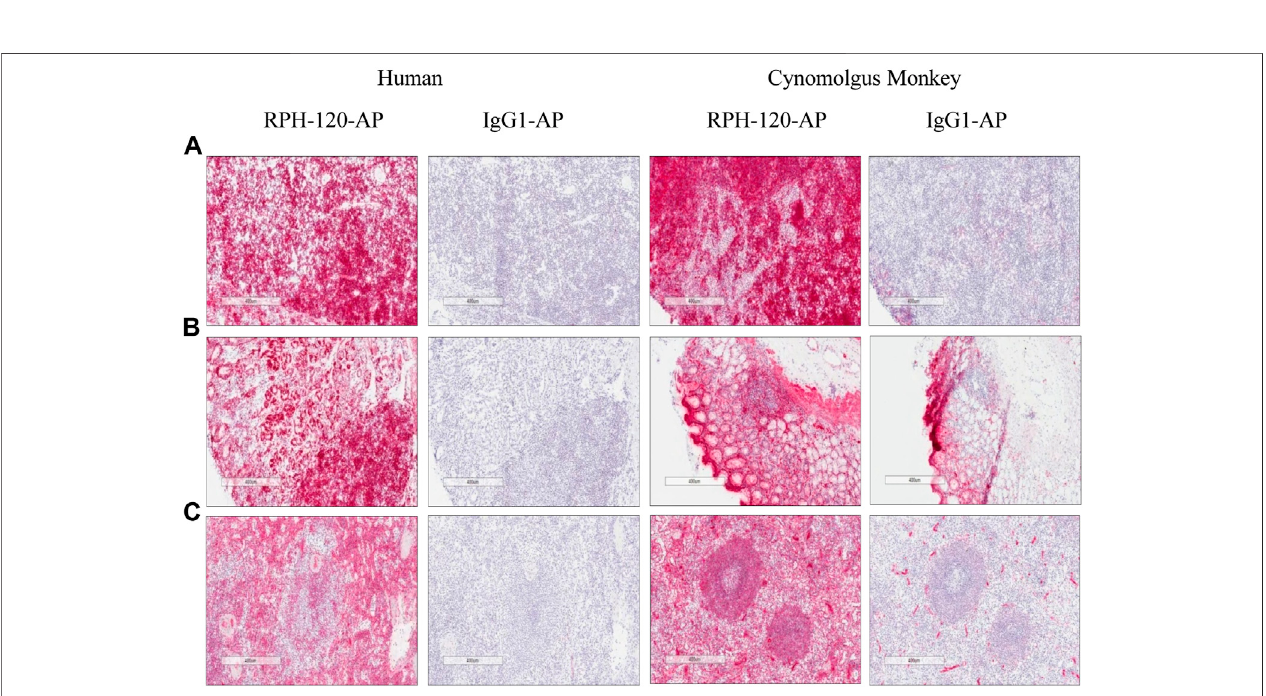
FIGURE 3 | IHC detection of endogenous PD-L1 by RPH-120 in several tissues. RPH-120 or control human IgG1 were conjugated to Alkaline Phosphatase (AP) and used for IHC studies. There are three groups of tissues from human and Cynomolgus monkey are shown here: Panel A : Lymph Node, Panel B Gastric Body tissue and Panel C -